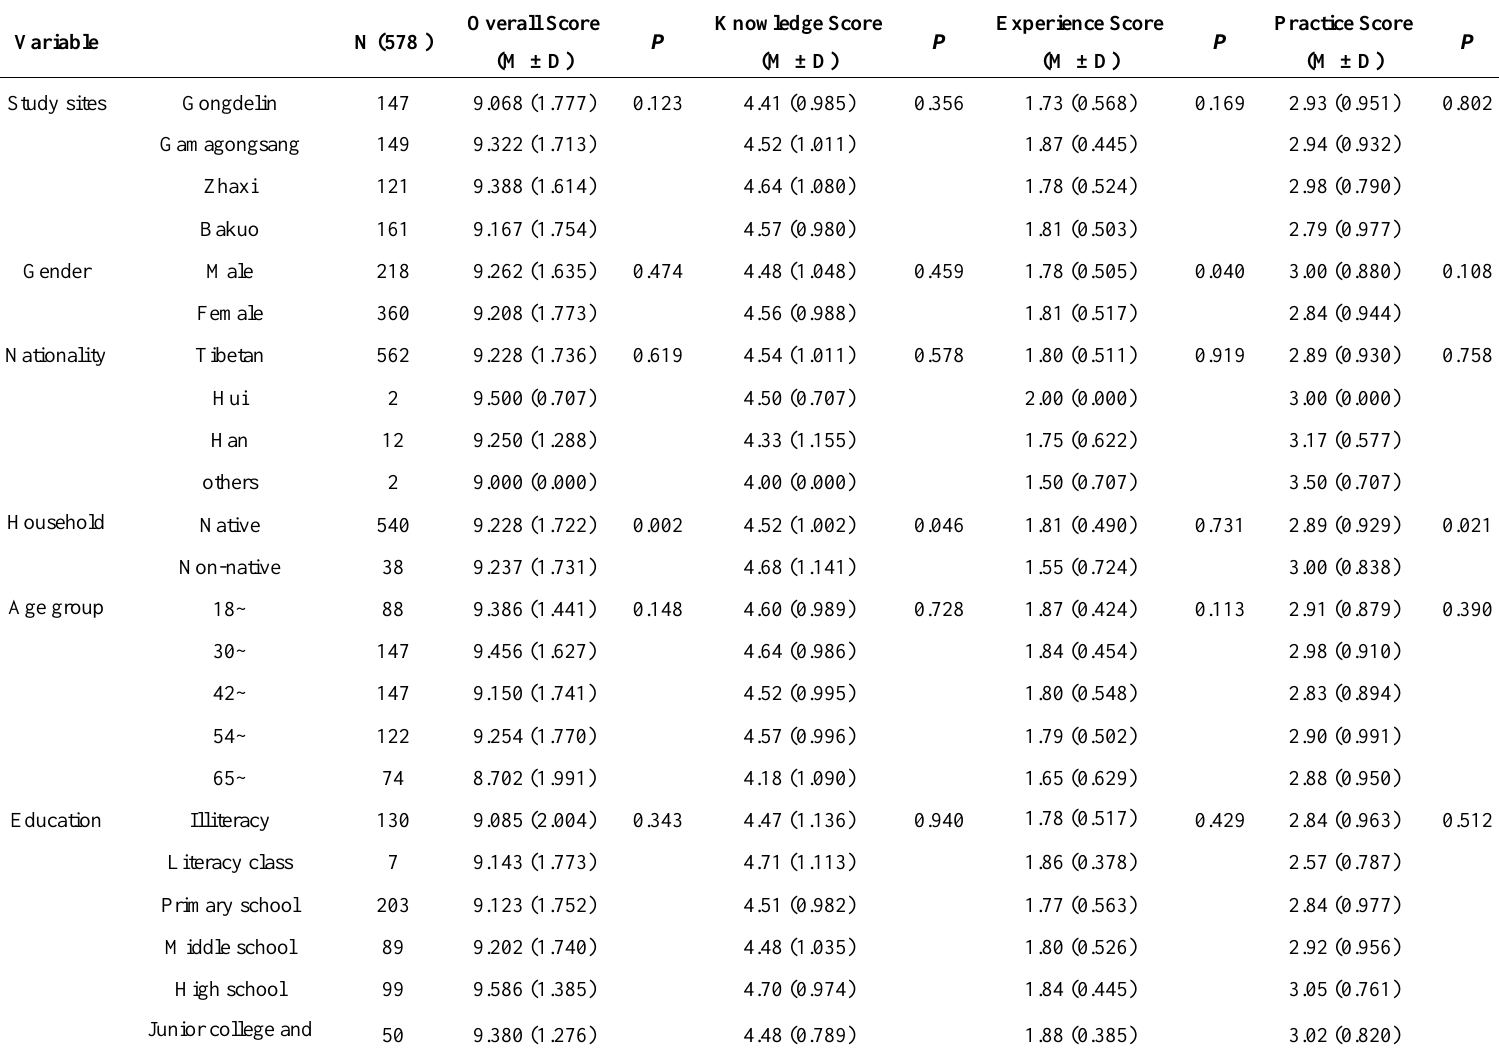
Table 3. Comparison of demographic characteristics and mean KEP